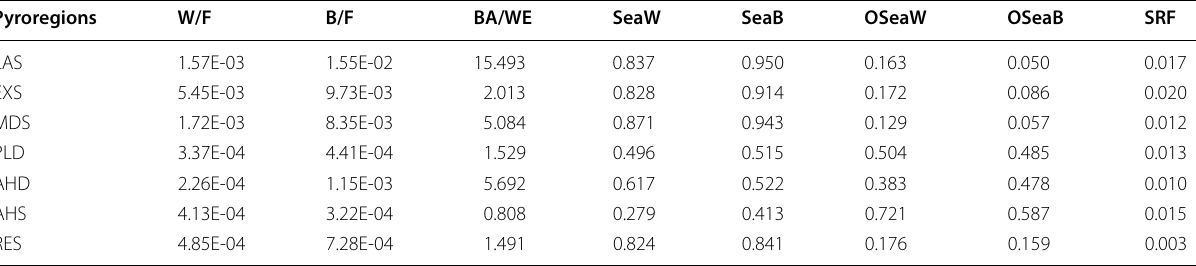
Table 3 Average values of the wildfire metrics used to perform the Affinity Propagation analysis grouped per cluster (see Table 1 for all codes and Fig. 3 for pyroregion acronyms)